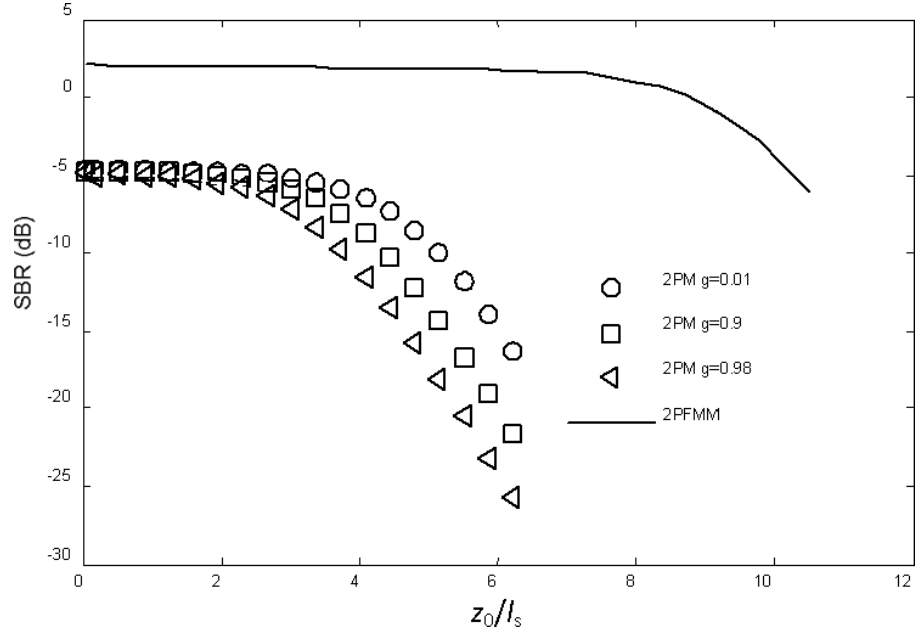
Fig. 16. The signal to background ratio of 2PFMM and 2PM as a function of focal depth z 0 . Simulation parameters are: l s ¼ 200 (cid:1) m, n ¼ 1 : 33, NA ¼ 5 = 9, and (cid:6) ¼ 0 : 9 (cid:1)